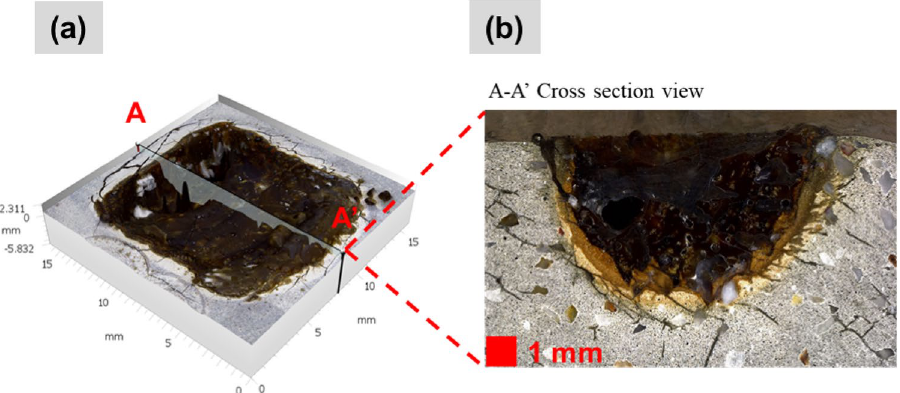
Figure 9. ( a ) Cross-section preparation, ( b ) Cross-sectional view of CM0.4 sample at 5 mm/s scanning speed.